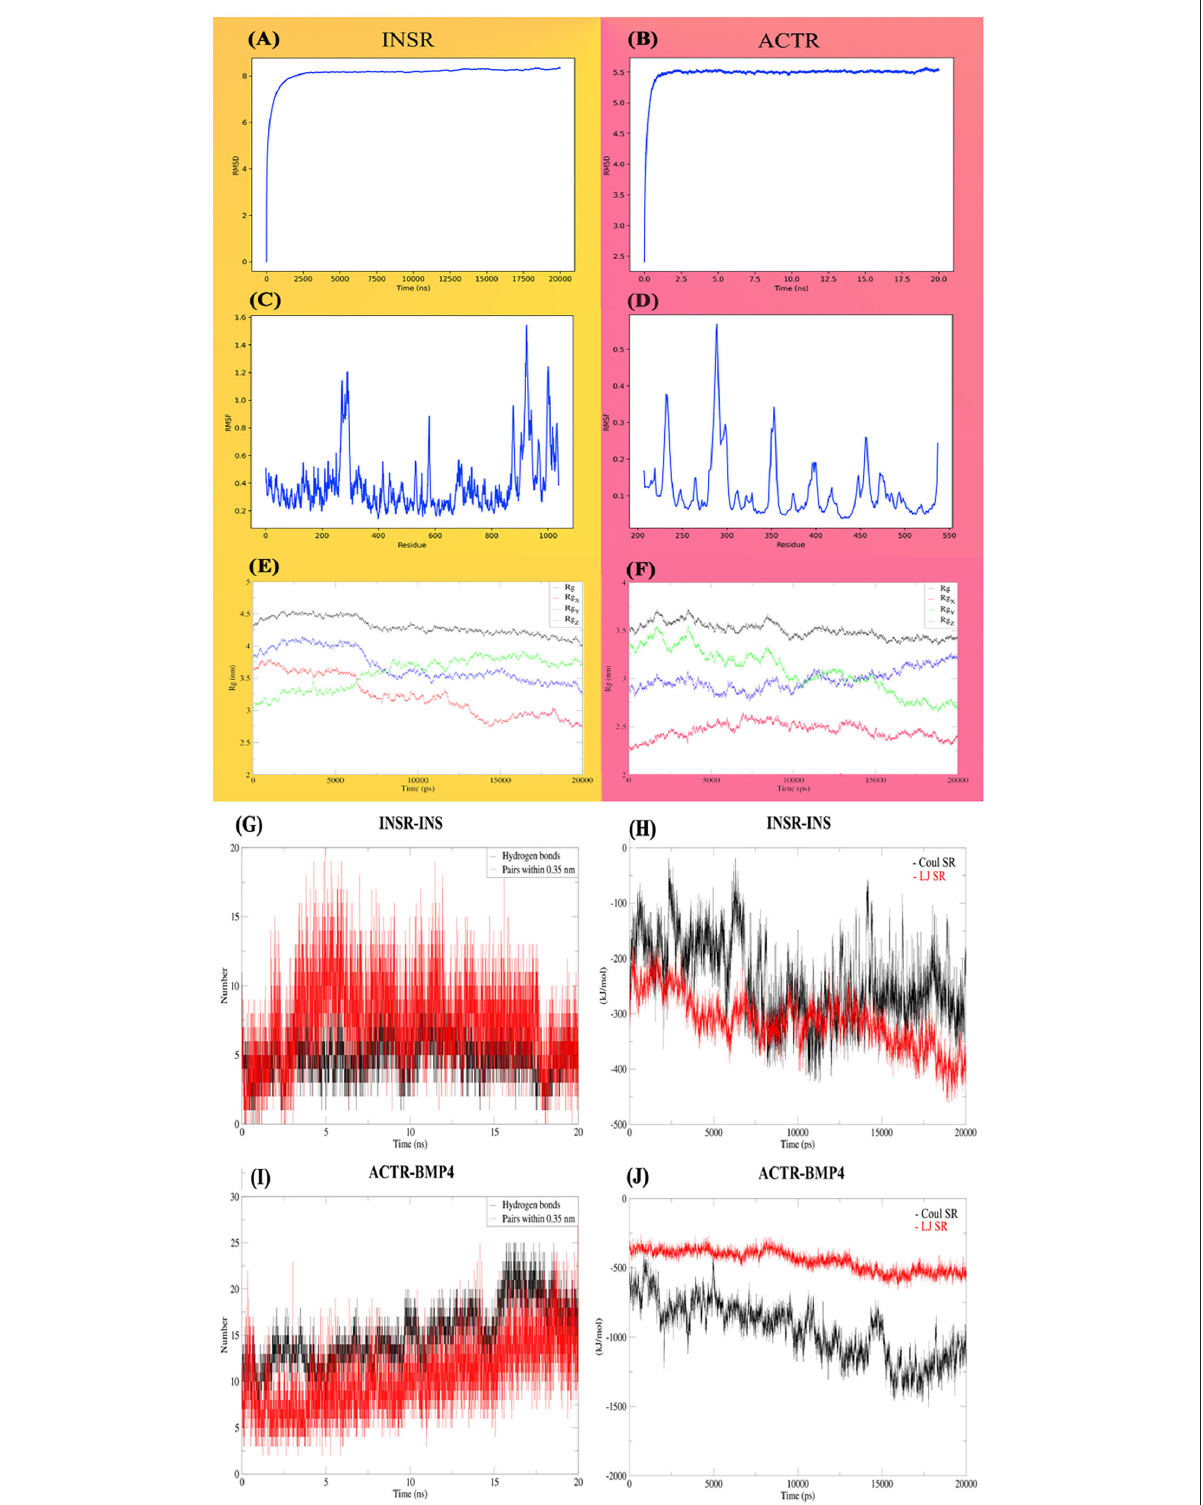
FIGURE7 Molecular dynamic analysis of the stability and interactions of INSR and ACTR receptors with their corresponding ligands. INSR and ACTR total and around the axes plots, RMSD (A, B) , RMSF (C, D) , and radius of gyration (Rg) (E, F) . Hydrogen bonds (G, H) and energies of interaction (I, J) , Coulomb, Lennard-Jones and, short-range